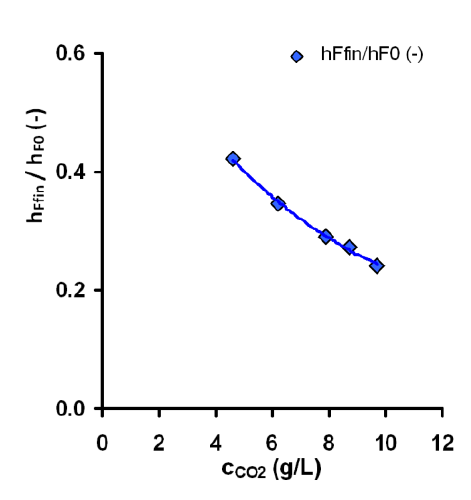
Fig. 10. Foam decay – effect of CO 2 content: h F fin / h F0 ratio